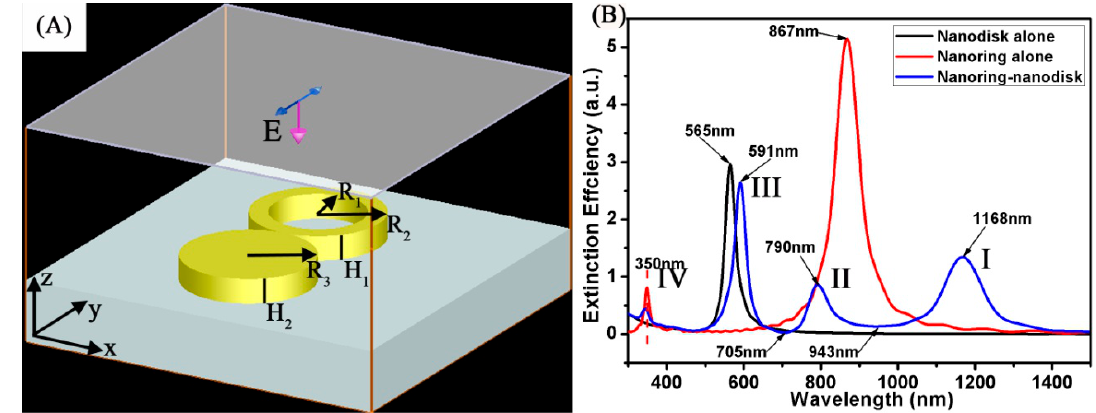
Figure 1. ( A ) Schematic illustration of the Au ring-disk nanostructures used in the simulations. ( B ) The spectrum calculated for the Au disk alone (black curve), Au ring alone (red curve), and Au ring-disk nanostructures (blue curve).